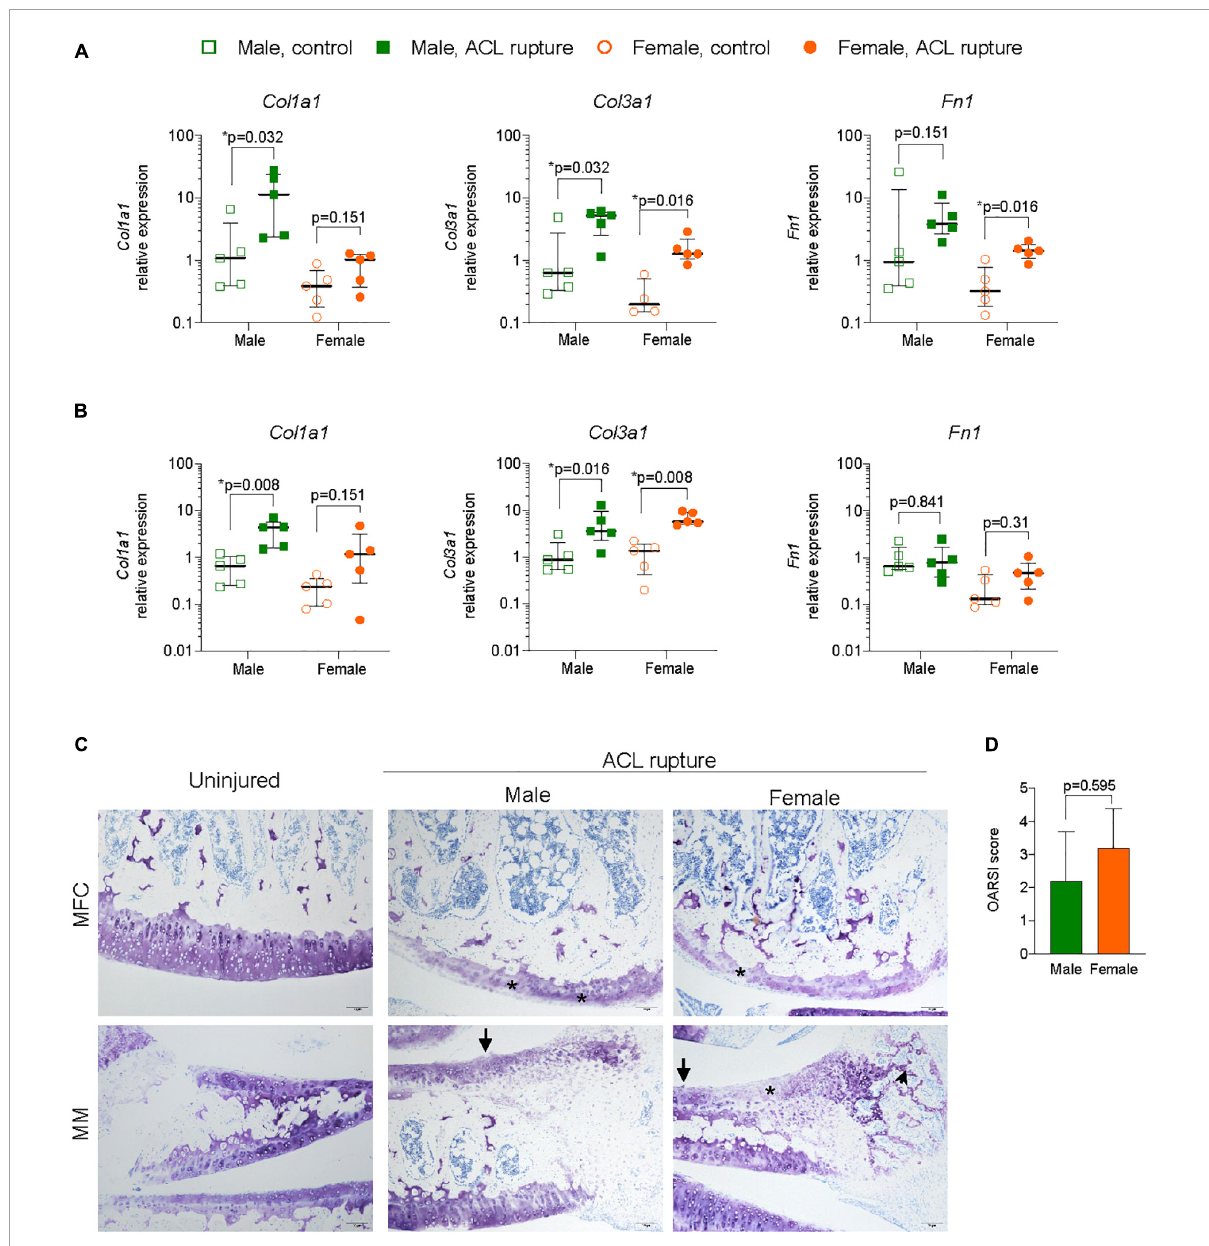
FIGURE6 Extacellular matrix (ECM) remodeling in articular cartilage. Relative expression of collagen type 1 and 3 (Col1a1, Col3a1), and fibronectin (Fn1) in (A) medial femoral condylar (MFC) cartilage, and (B) medial meniscus (MM) of male and female animals at day 31 following ACL rupture. (C) Representative toluidine blue-stained sections of MFC (upper panels) and MM (lower panels) in uninjured and ACL-ruptured knees (magnification, 100 × ). Proteoglycan loss (asterisk) and surface fibrillation (arrows) was evident in MFC and MM, while disorganized ECM deposition was increased in the outer zone of the MM (arrowhead) of injured knees (magnification, 100 × ). (D) Osteoarthritis Research Society International (OARSI) scoring of medial articular cartilage surfaces in male and female animals at day 31 following ACL rupture. Data show median ± IQR. Mann-Whitney U -test, * p <